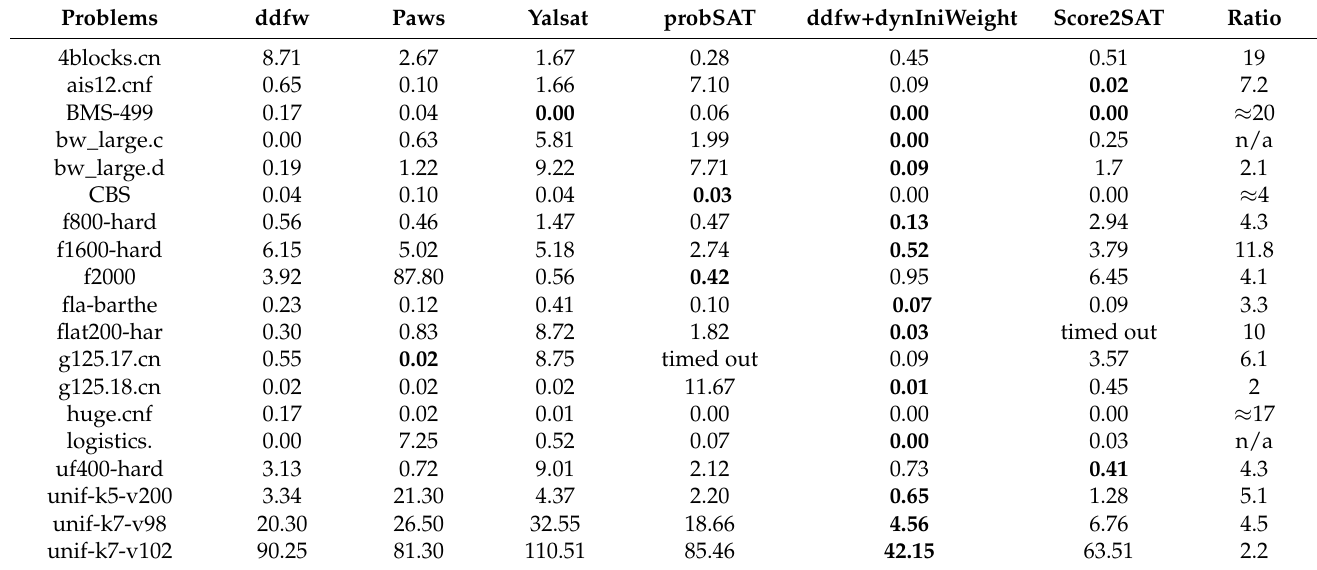
Table 3. Results for the DIMACS problems